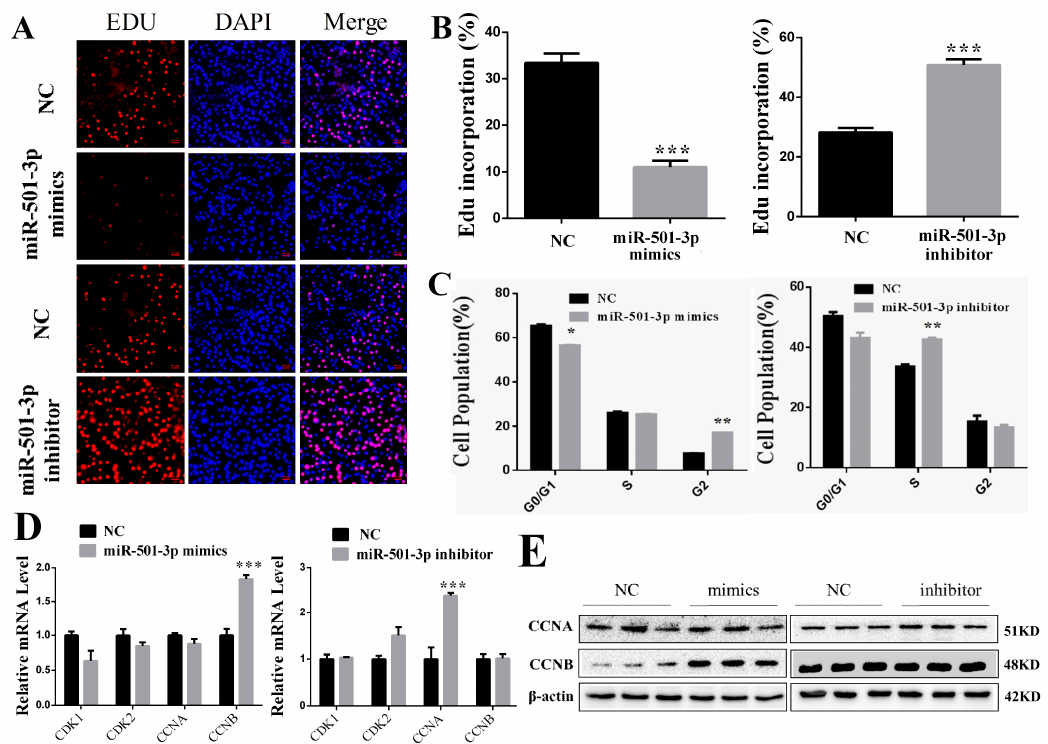
Figure 2. MiR-501-3p inhibits C2C12 proliferation. ( A ). MiR-501-3p mimics lowered the percentage of Edu-positive C2C12, and miR-501-3p inhibitor increased the percentage of Edu-positive C2C12. Representative images of the immunofluorescent staining for proliferating C2C12 are shown. Proliferating C2C12 were labeled with Edu fluorescent dye (red). ( B ) The quantitative data of proliferating C2C12 in Figure 2A. ( C ) The different cell phases analyzed by flow cytometry. ( D ) qRT-PCR confirmed miR-501-3p is negatively correlated with proliferation-related genes in C2C12 transfected with miR-501-3p mimics and inhibitor. ( E ) Western blot result shows that the protein level corresponded to the mRNA result. * p < 0.05, ** p < 0.01, *** p < 0.001. The results are presented as mean ± S.E.M. of three replicates for each group. Magnification 100 × . The scale bar on the photomicrographs represents 50 µ